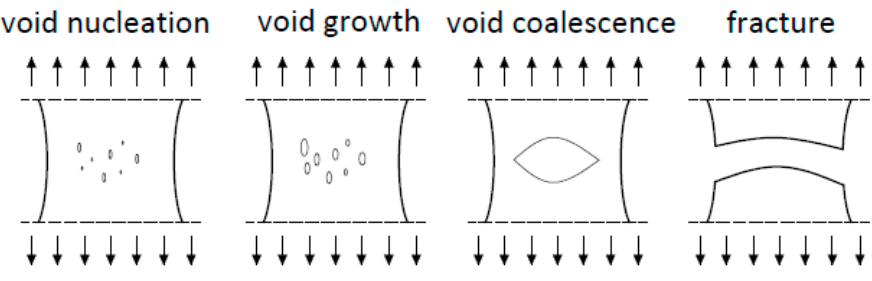
Figure 5. Mechanism of ductile fracture. Therefore, the material strength, defined by the normal stress σ , is closely related to its damage. The stress value begins to decrease at the moment of void initiation. Void is reached